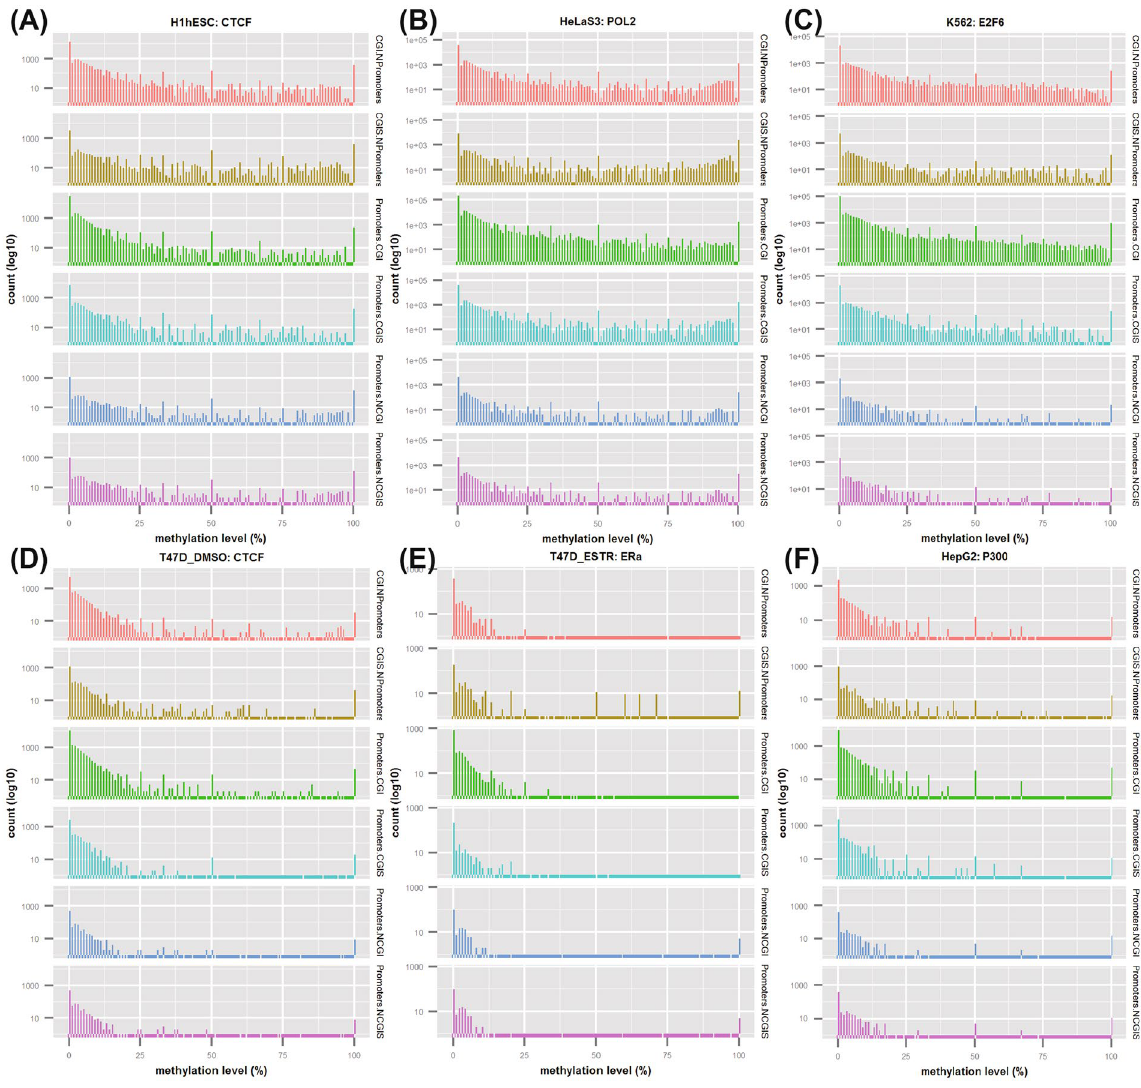
(ESTR) and HepG2, within the cell-type and TF combinations. X-axis depicts the methylation level distribution (0~100%) and y-axis for the CpG loci (sites) count at each specific methylation